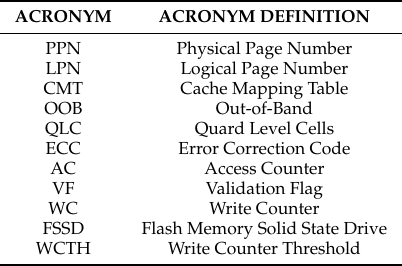
Table 2. Acronyms used in the